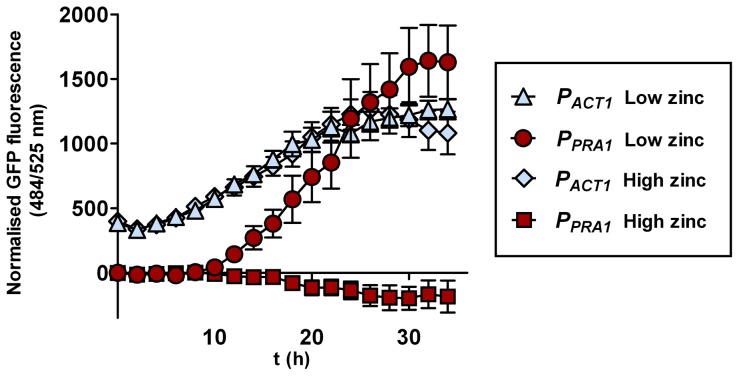

PRA1 expression is zinc regulated.
C. albicans harbouring GFP under control of either the ACT1 (PACT1-GFP, M135) or PRA1 (PPRA1-GFP, M1522) promoter were incubated in Lee's medium, pH 7.4 either with or without supplementation with (100 µM) zinc. GFP fluorescence was determined at indicated time points and normalised against a C. albicans strain harbouring an empty vector. Note that the addition of zinc fully suppresses expression from the PRA1 promoter. Experiment was performed three times in triplicate.